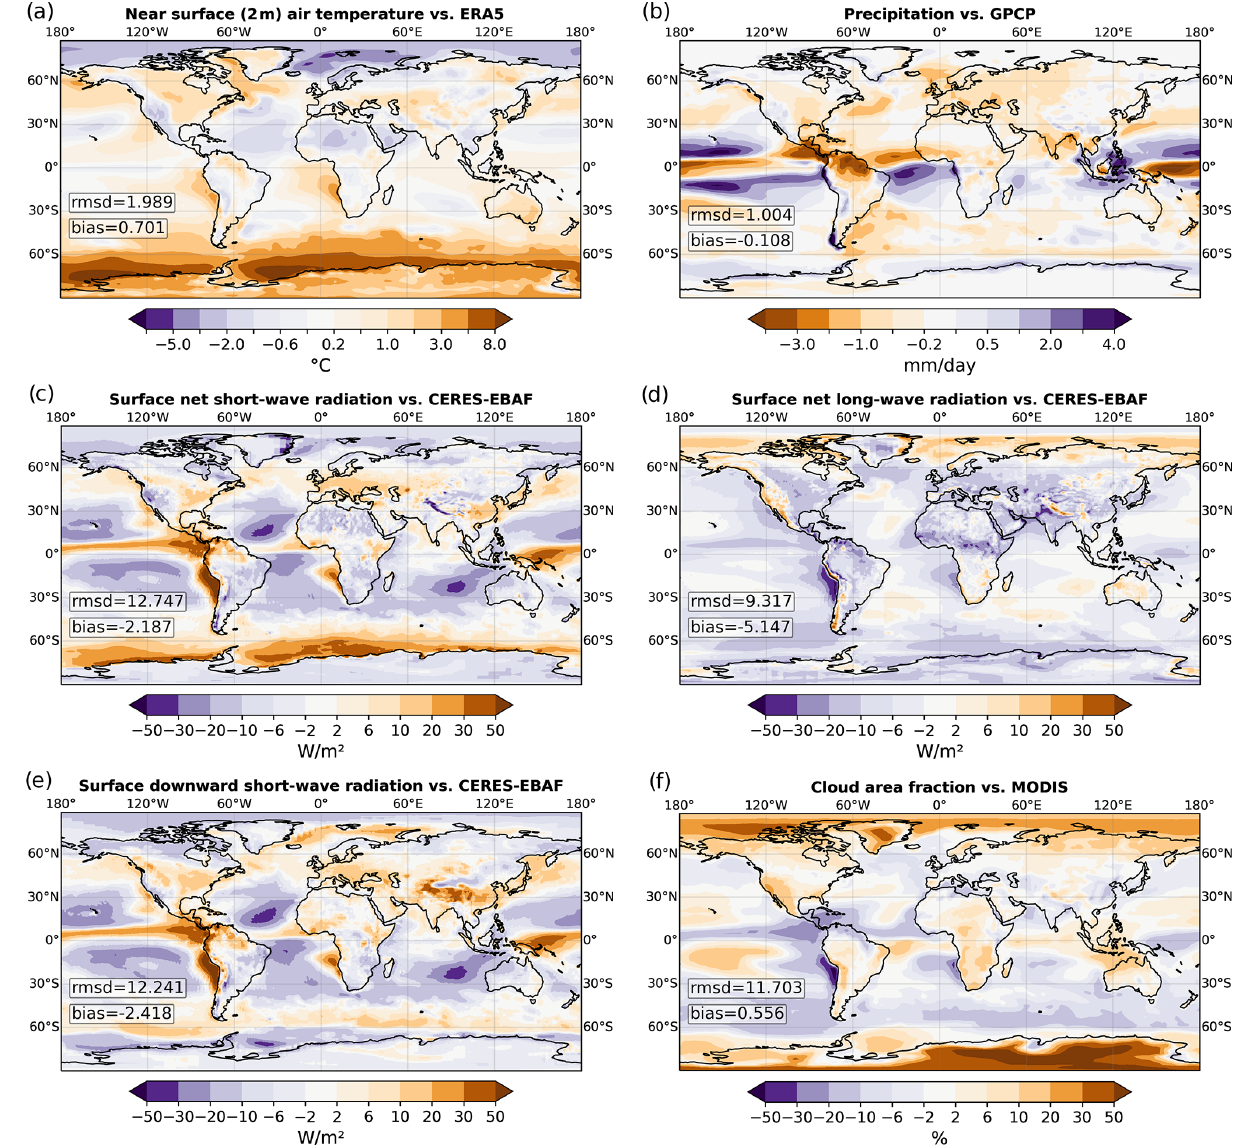
Figure 6. Annual mean (a) near-surface (2m) air temperature bias with respect to ERA5, (b) precipitation bias with respect to GPCP, (c) surface net shortwave radiation bias with respect to CERES (2001–2014), (d) surface net longwave radiation bias with respect to CERES (2001–2014), (e) surface downward shortwave radiation bias with respect to CERES (2001–2014), and (f) total cloud cover fraction bias with respect to MODIS. For each variable rmsd gives the area-weighted root mean square distance between observations and model data, and bias gives the area-weighted mean